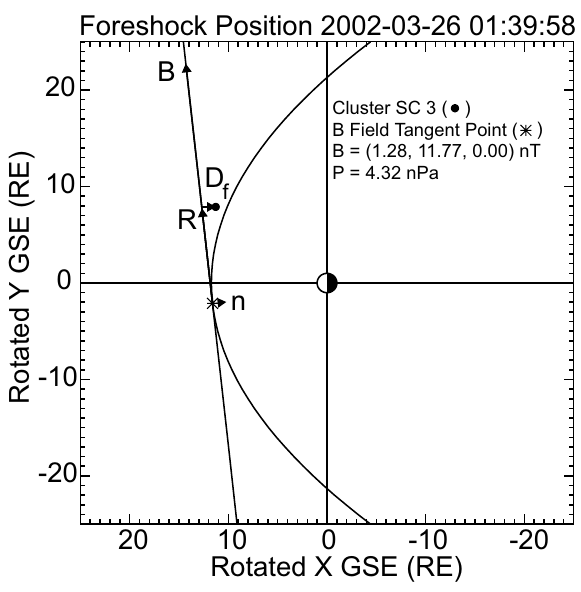
Fig. 1. Illustration of the foreshock coordinate system for Cluster spacecraft 3 on 26 March 2002 at 01:39:58 UT.